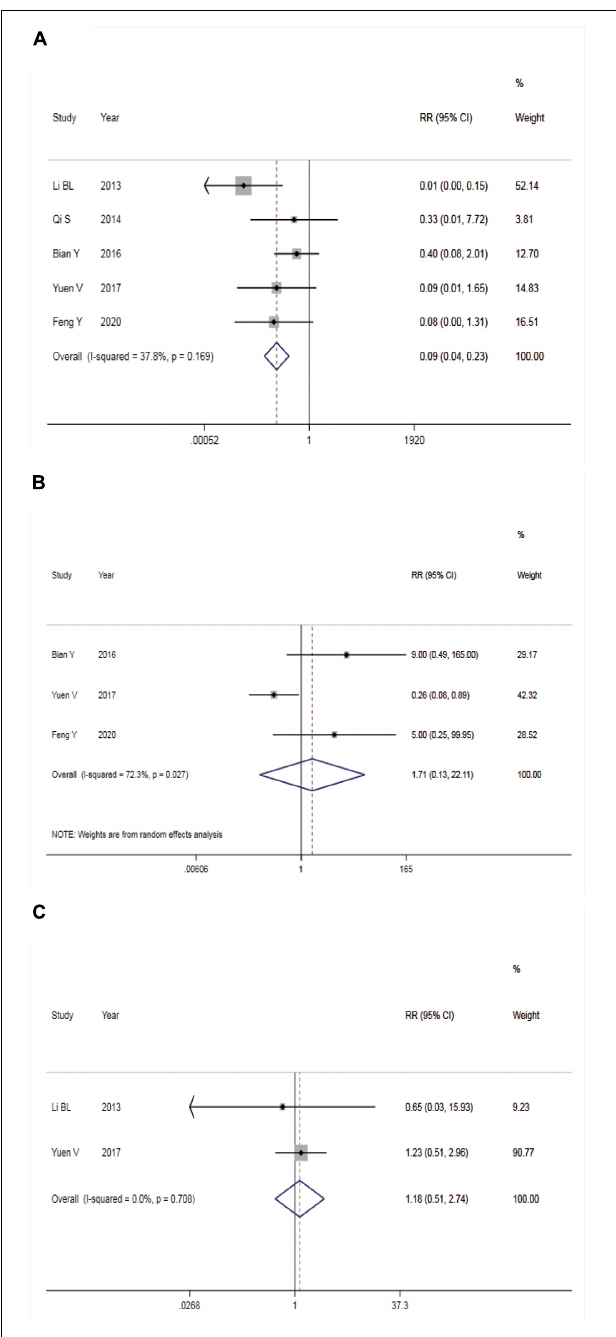
FIGURE 4 | Safety of dexmedetomidine vs. Chloral hydrate on CT/MRI sedation in children. (A) Incidence of nausea and vomiting; (B) incidence of bradycardia; (C) incidence of